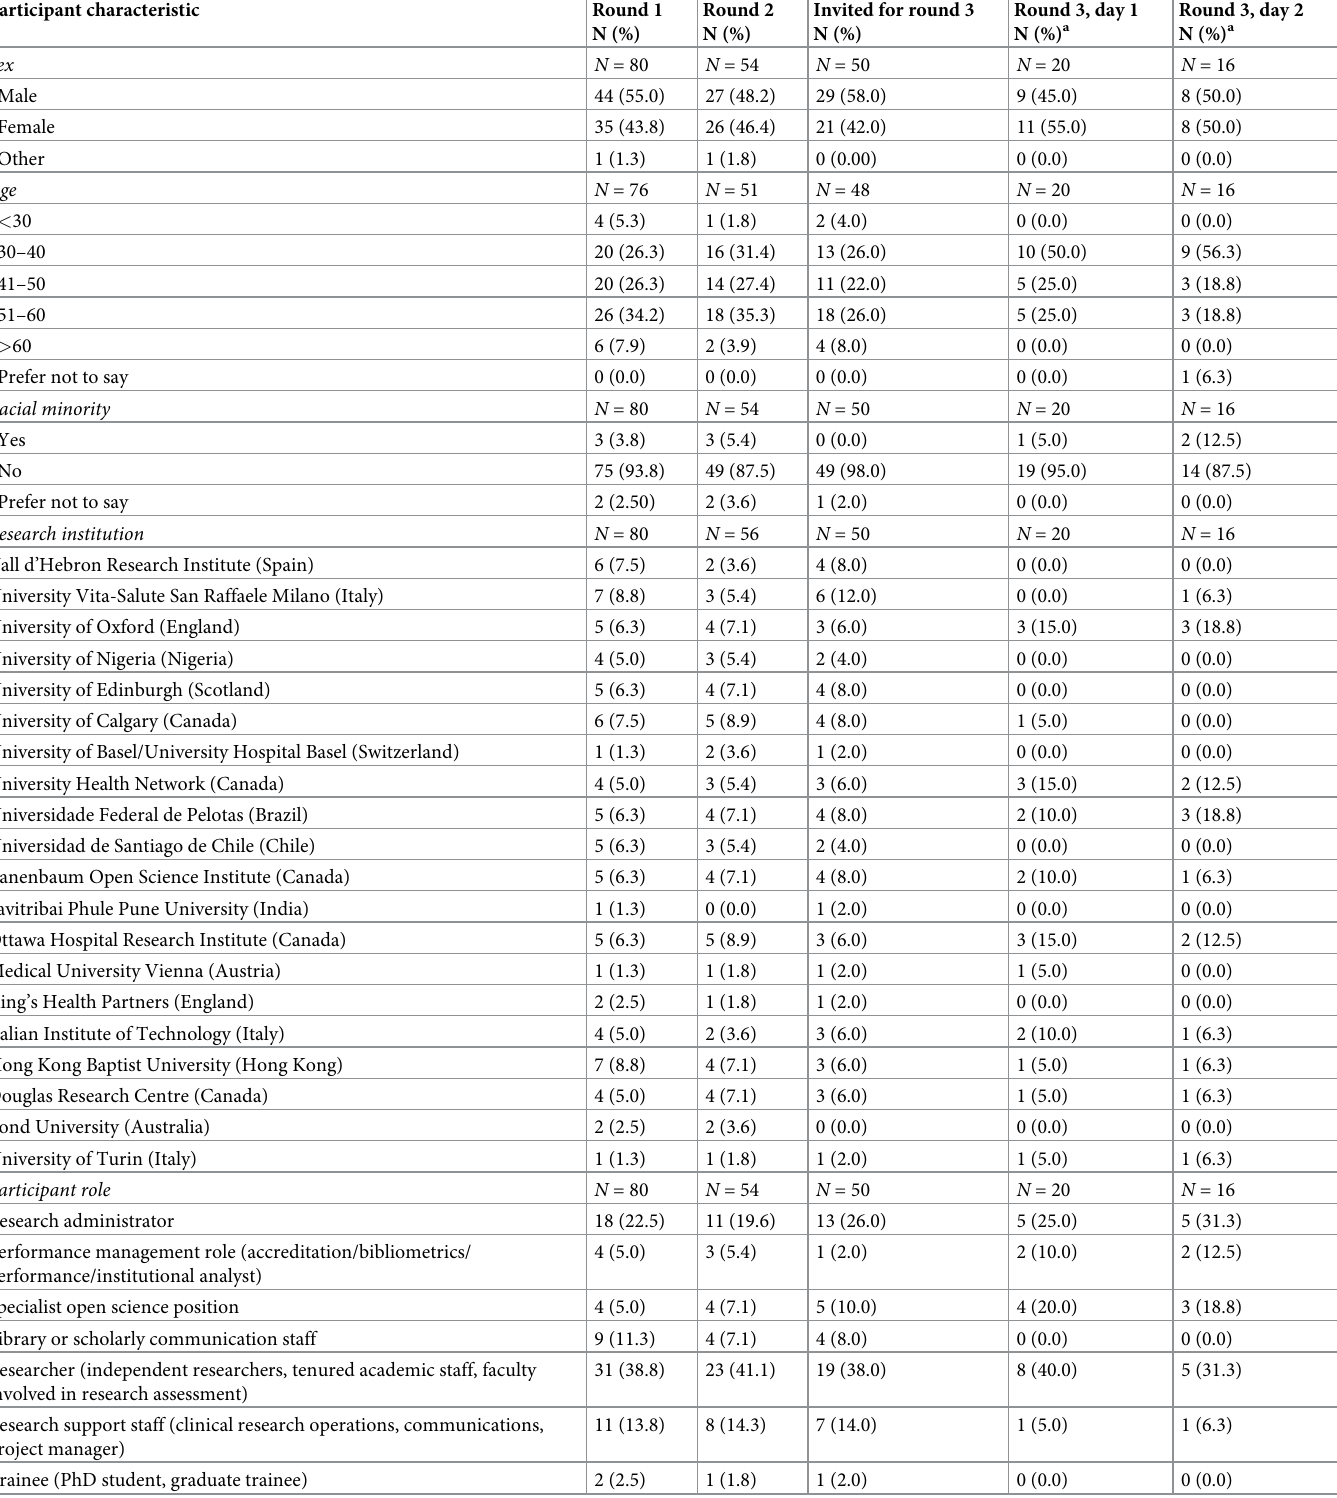
Table 1. Characteristics of participants in the Delphi